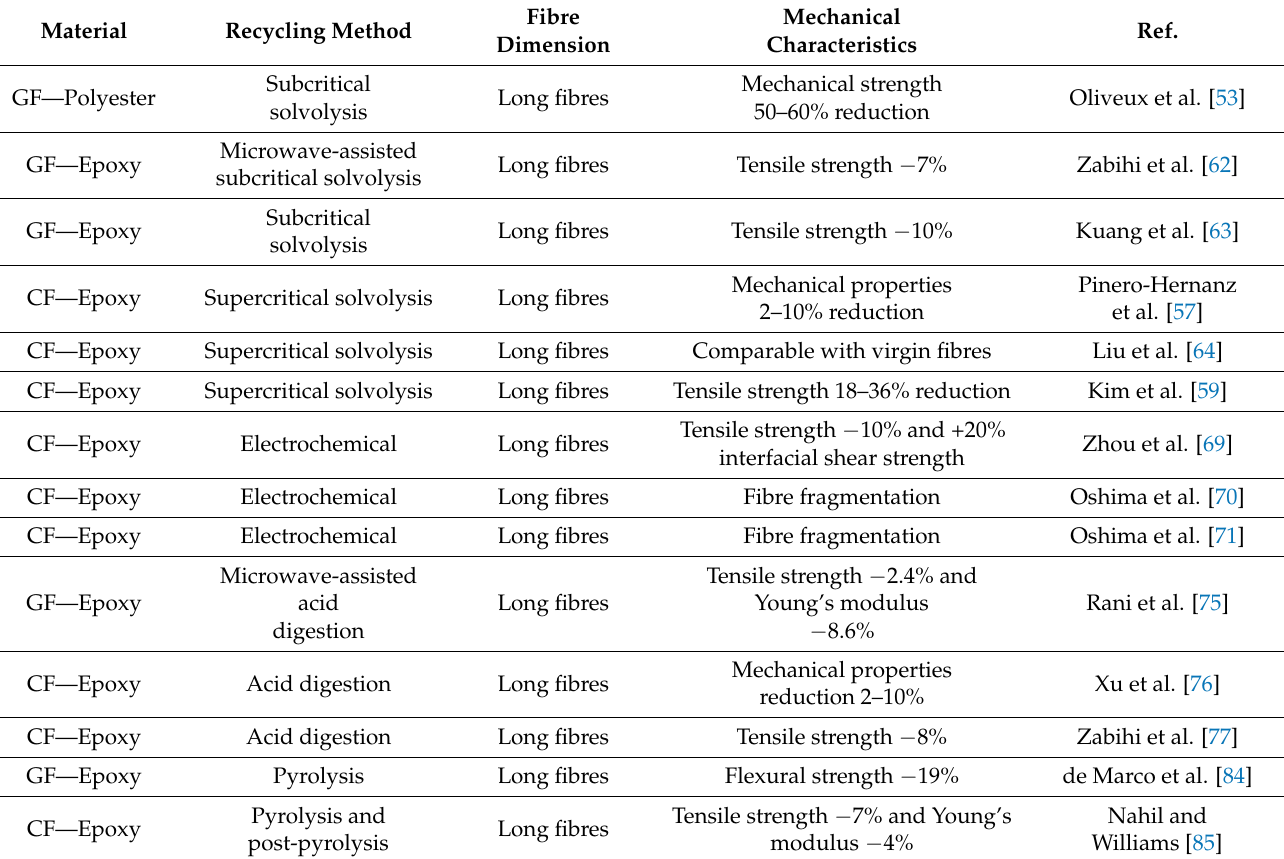
Table 7. Main recycling methods of CFRP and GFRP composite